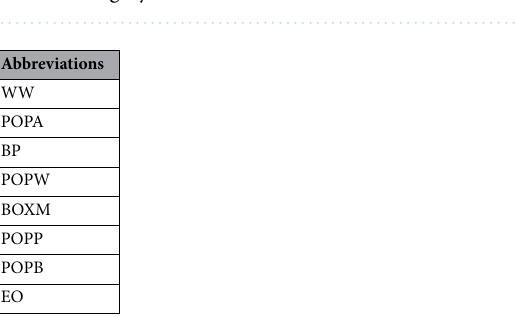
Figure 9. Location of the study area, the ‘Gemenc forest’, Hungary.